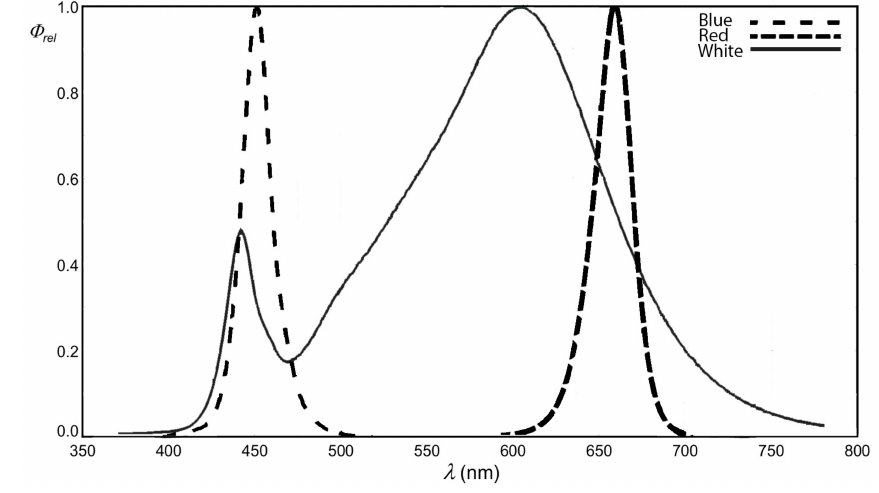
Figure 7. LED emission